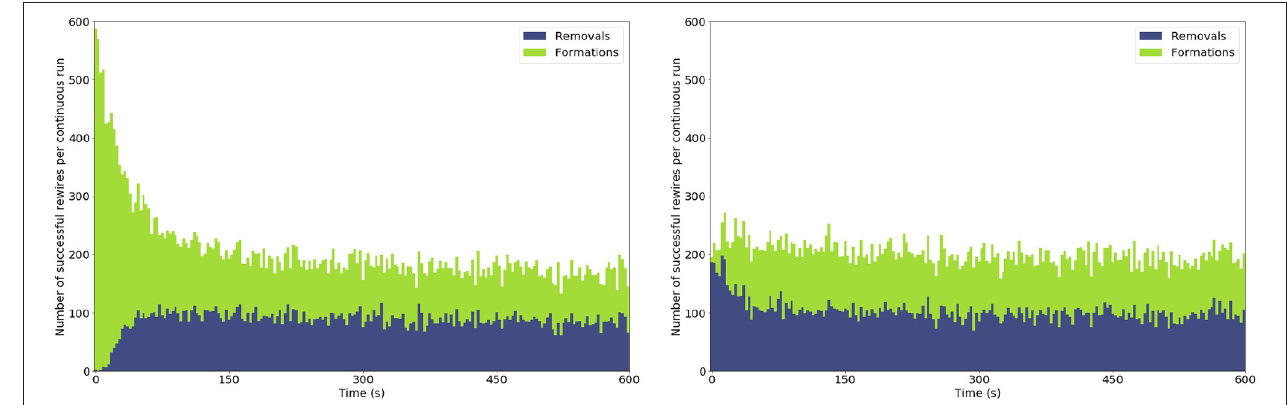
FIGURE 6 | Stacked bar chart of formations and removals over time within one simulation. (Left) evolution of the network starting from no connections; (Right) evolution of the network starting from a sensible initial connectivity. The number of formations or removals is aggregated into 3 s chunks.